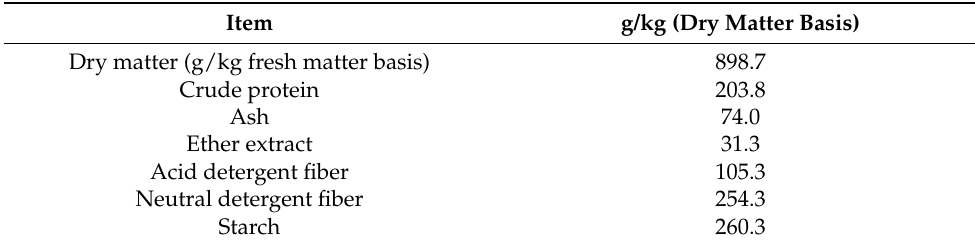
Table 1. Chemical composition of dairy cow concentrate